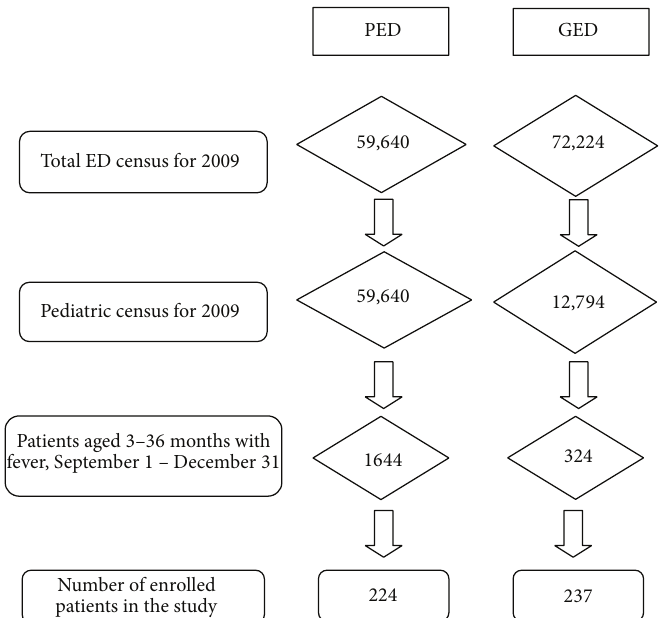
Figure 1: Hospital ED census and enrollment numbers are given for the study period, September 1, 2009, to December 31, 2009.